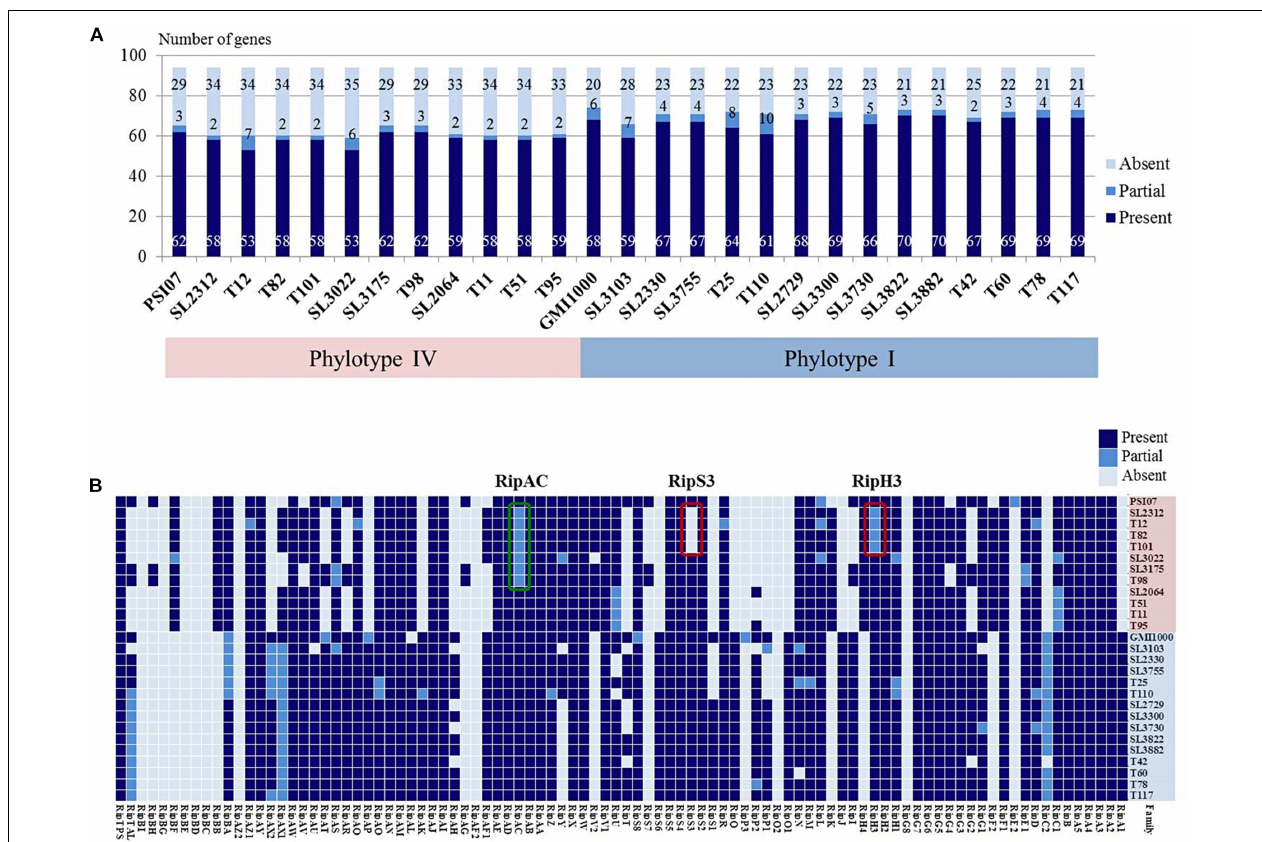
FIGURE 4 | (A) Graph of predicted effector gene numbers. The colors represent as follows: dark blue, presence of a gene; blue, partial gene; light blue, absence of a gene. (B) Distribution of the T3e genes in 25 Korean strains and the reference GMI1000 and PSI07 strains. Red boxes represent tomato-non-pathogenic strains and green box represent eggplant-non-pathogenic